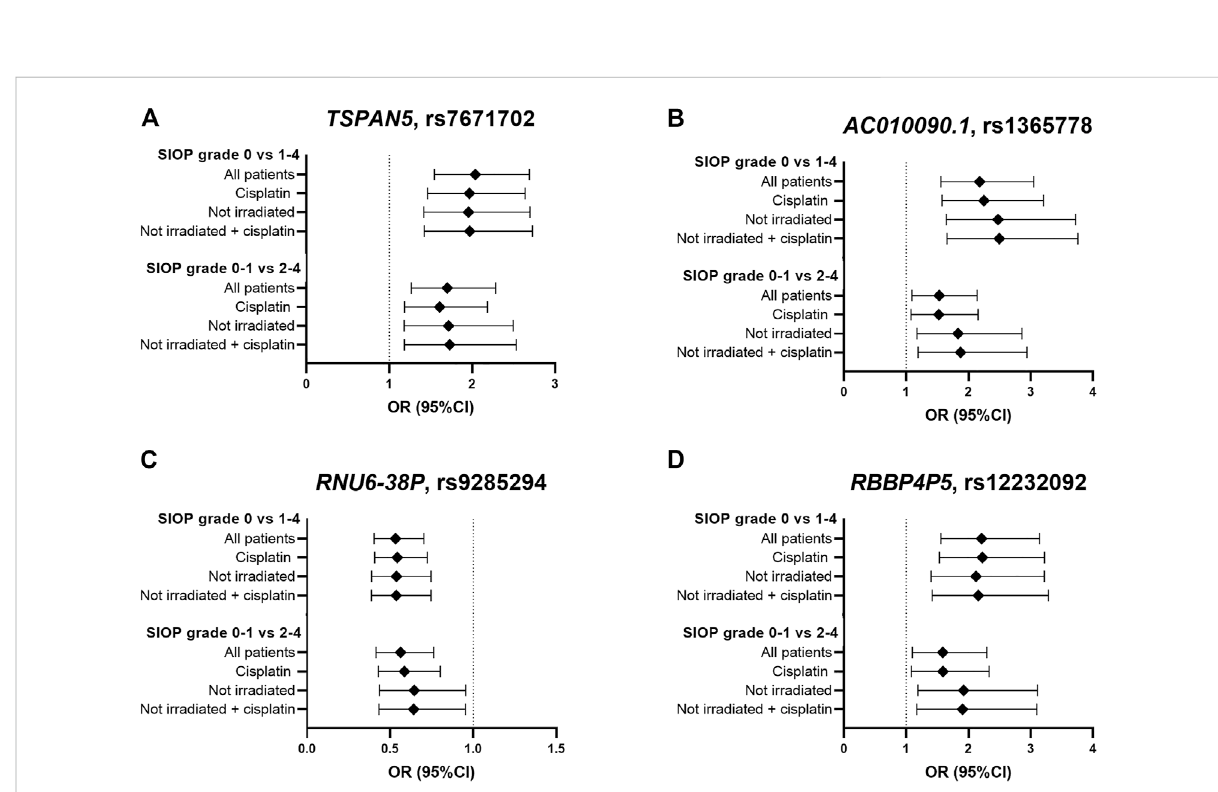
Results in primary and secondary analyses of four variants (A – D) that were suggestively associated with platinum-induced ototoxicity in the primary GWAS meta-analysis. The top bar represents the primary analysis (SIOP grade 0 vs 1 – 4, “ all patients ” ). In the “ cisplatin ” subgroup, patients treated with carboplatin were excluded and in the ‘ not irradiated ’ subgroup, patients that received cranial irradiation were